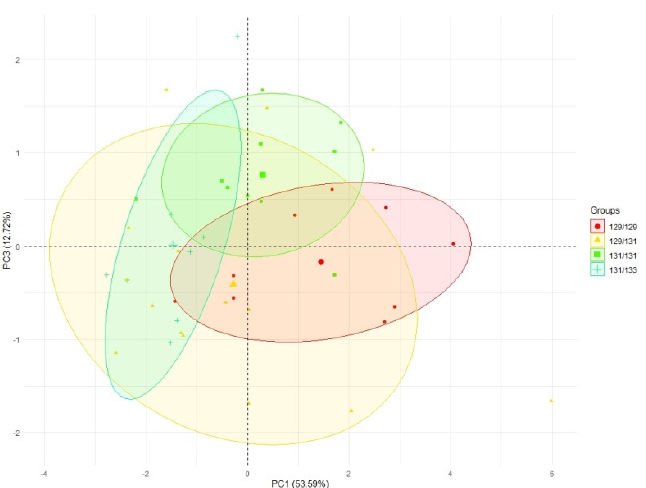
Figure 1. PCA for the SW245 marker, for both breeds analyzed together: A scatterplot of PC1 against PC3, with the indication of the genotype. PC1 was positively correlated with both the number and the percentage of stillborn piglets, and negatively correlated with the percentage of number live-born and the number of weaned piglets. PC3 was negatively correlated with the percentage of weaned piglets. The axes represent loadings onto components 1 and 3, while the four ellipses represent the four genotypes. Table 6. Summary statistics of the traits related to litter size in the Polish Large White sows.